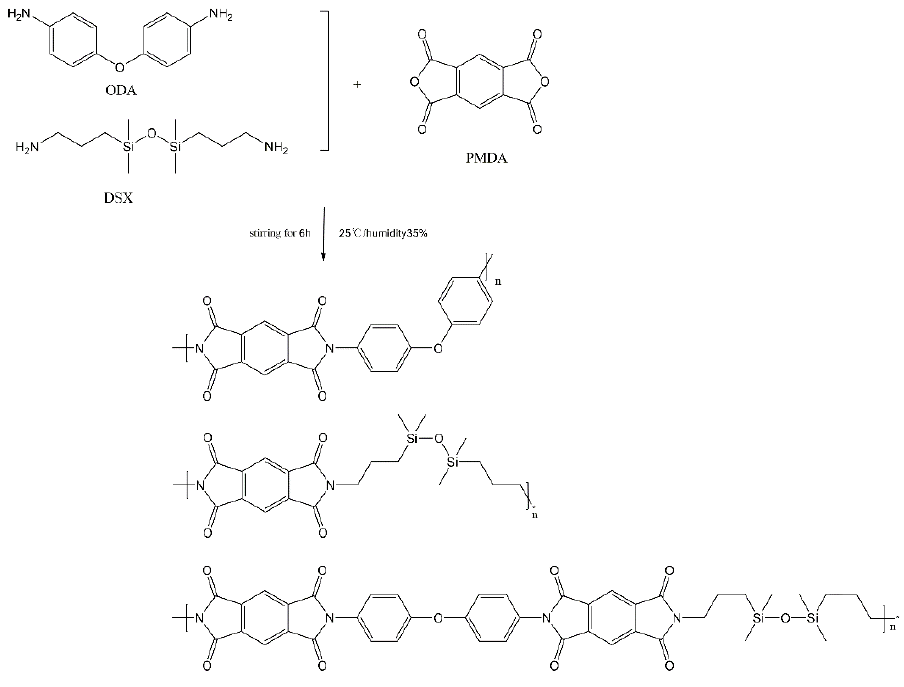
Figure 1. Synthesis path of polyimide (PI) films in group 1.